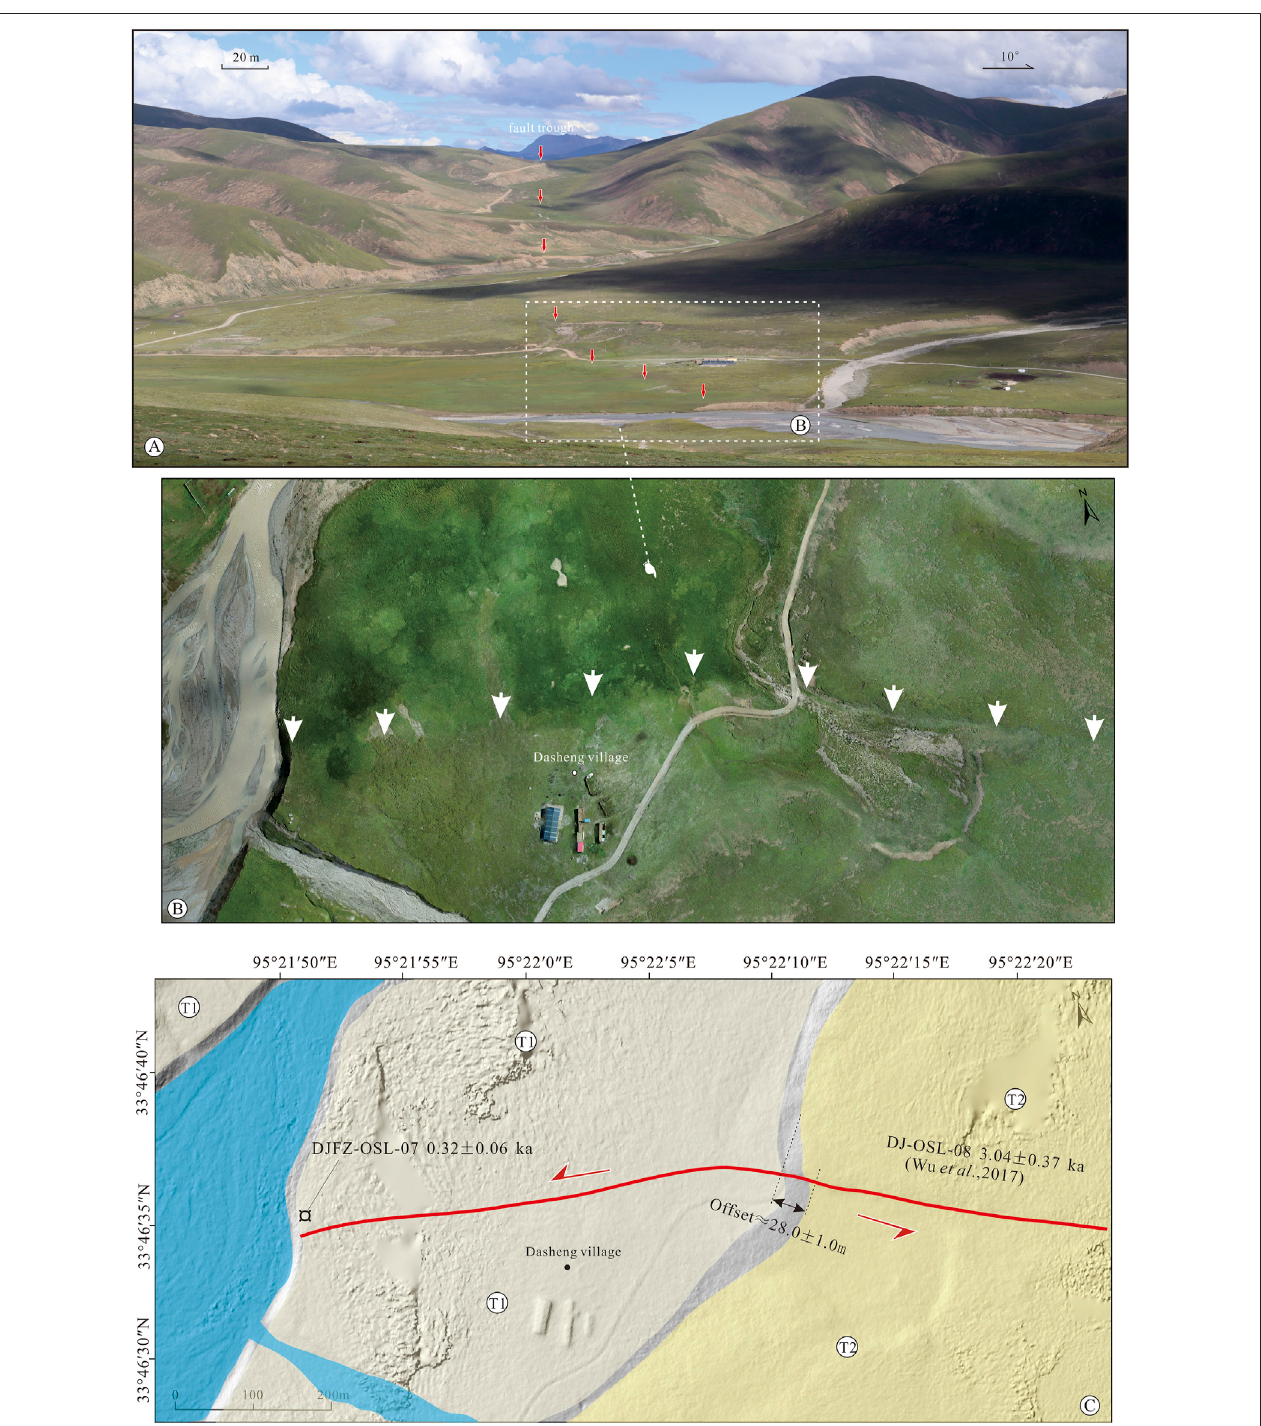
FIGURE 11 | Tectonic geomorphic features in Dasheng village along the western section of the DJF (the study site is marked in Figure 3 W). (A) Fault activity formeddistincttroughsandvalleys,andtheredarrowsinthemapdelineatethefaulttrace. (B) TheorthophotoimagetakenfromadroneshowsthatriverterracesT1and T2 are displaced by the activity of the DJF. (C) Interpreted map and fi eld investigation further reveal that the horizontal displacements of terrace T2 are ~28.0 ± 1.0 m.